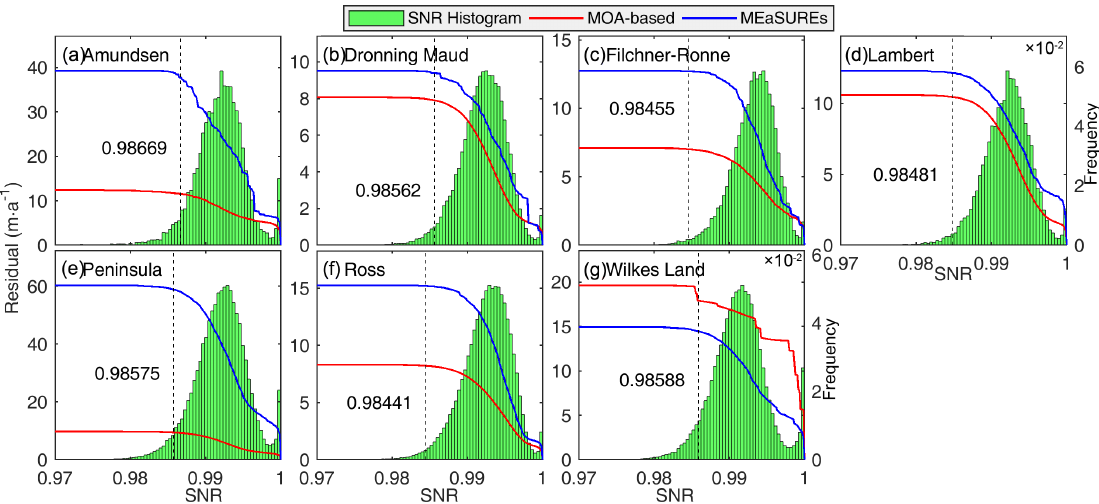
Figure 5. The SNR distribution histogram, the residual speed with the SNR in the rock outcrop, and the corresponding SNR threshold labeled as a vertical dash-line in seven drainages: ( a ) Amundsen, ( b ) Dronning Maud, ( c ) Filchner-Ronne, ( d ) Lambert, ( e ) Peninsula, ( f ) Ross, ( g ) Wilkes Land. Note that the scale of the left Y axis in each panel